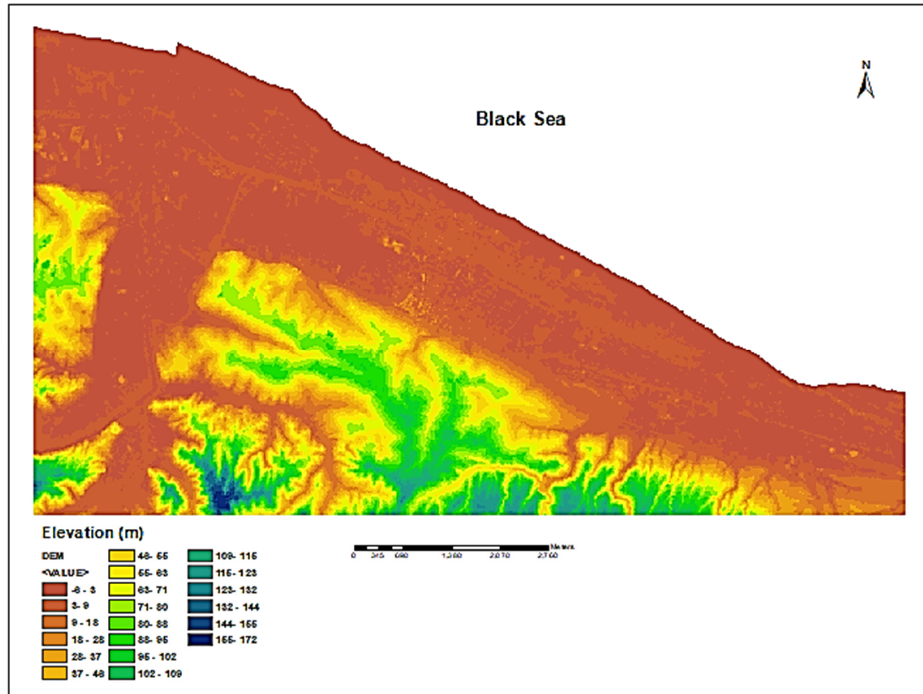
GDP. The population of the Karasu Coastal Area is 59,130 people, and the GDP per capita